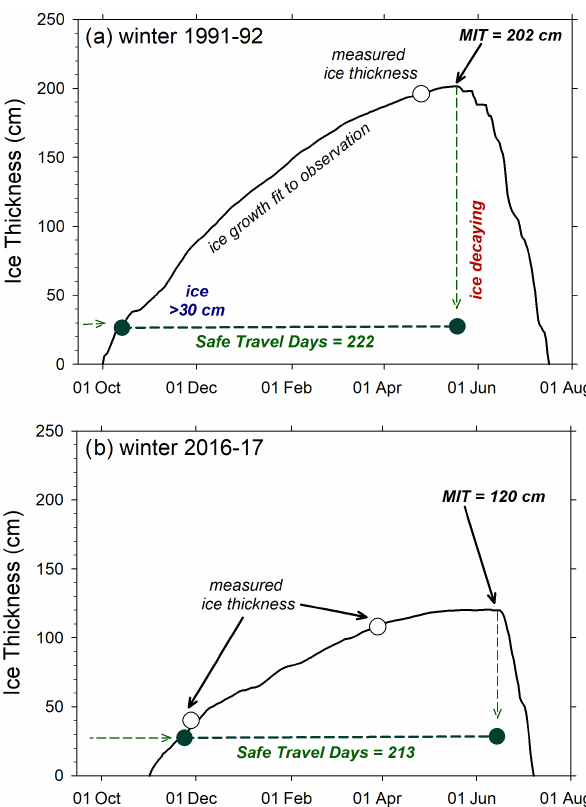
Figure 3. Example ice growth and decay curves from Barrow lakes in a thick (a) and thin (b) ice year showing curve fits to observed data, the time when maximum ice thickness (MIT) is reached, and the period representing ice travel duration (ITD).